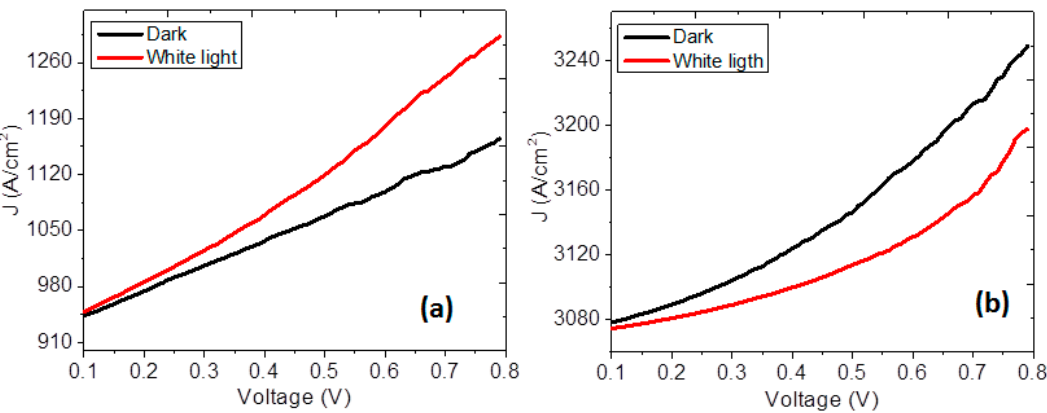
Figure 8. J - V characteristics of the investigated devices D3 and D4 with ( a ) FHJ and ( b ) BHJ active